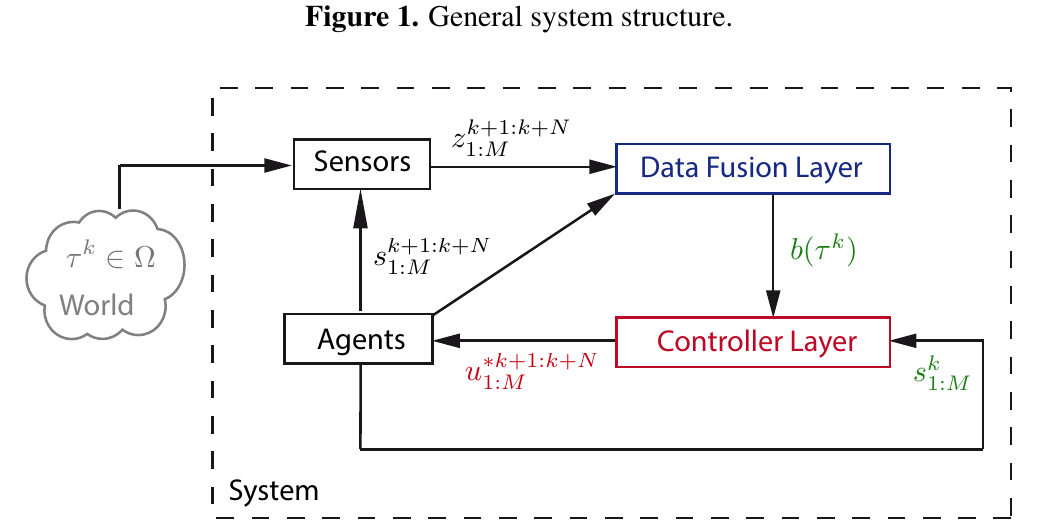
Figure 1. General system